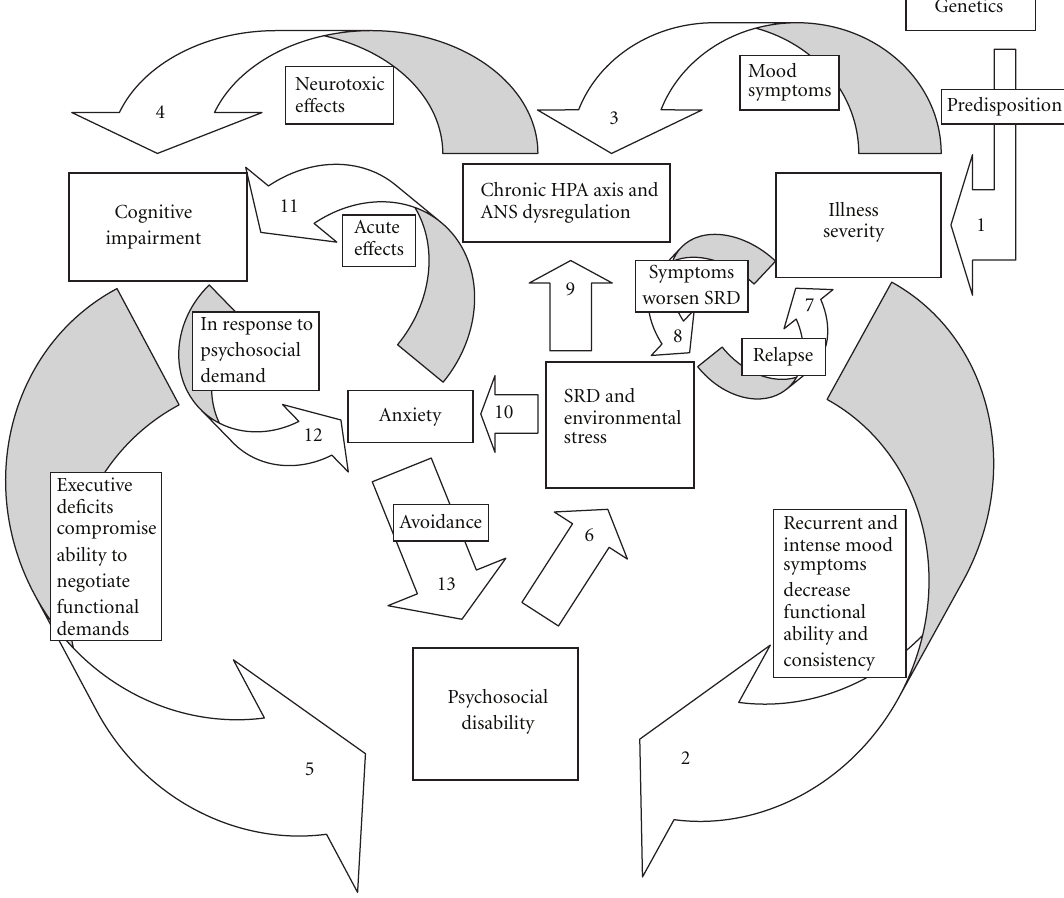
Figure 1: The malignant cycle in bipolar